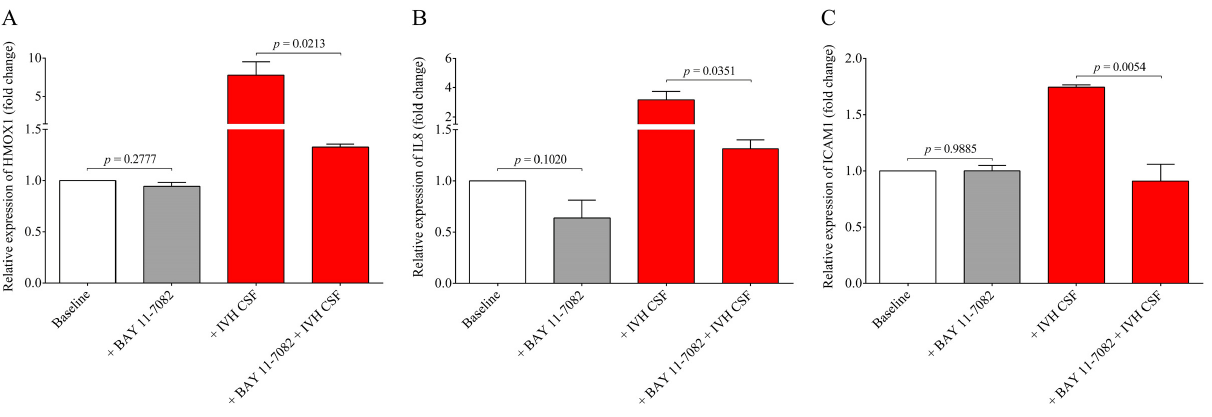
Figure 8. Investigation of the NF- κ B pathway-dependent inflammatory response in HCPEpiCs using a specific inhibitor. HCPEpiC cells were pretreated with the NF- κ B pathway inhibitor BAY 11-7082 (5 µ M) for 4 h (gray bar) and then exposed to IVH CSF (red bar) samples (10 v / v %) for 24 h. In the presence of BAY 11-7082, we detected significantly lower HMOX1 ( A ), IL8 ( B ), and ICAM1 ( C ) mRNA levels than samples with IVH CSF alone. The inhibitor alone did not alter these levels compared to the baseline samples. Mean ± SEM values are depicted, n = 3–4/group. The ANOVA test with Bonferroni’s multiple comparison test was used for comparison. Abbreviations: CSF, cerebrospinal fluid; HCPEpiCs, human choroid plexus epithelial cells; HMOX1, heme oxygenase 1; ICAM1, intercellular adhesion molecule 1; IL8, interleukin 8; IVH, intraventricular hemorrhage; mRNA, messenger RNA; and NF- κ B, nuclear factor-kappa